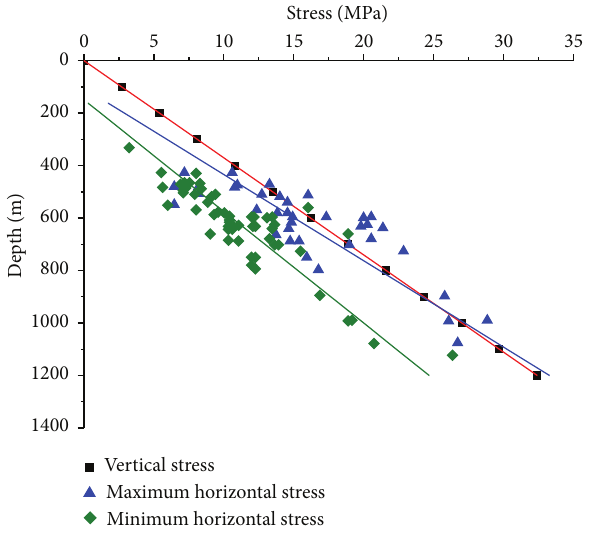
Figure 6: The strata stress in the SQB.